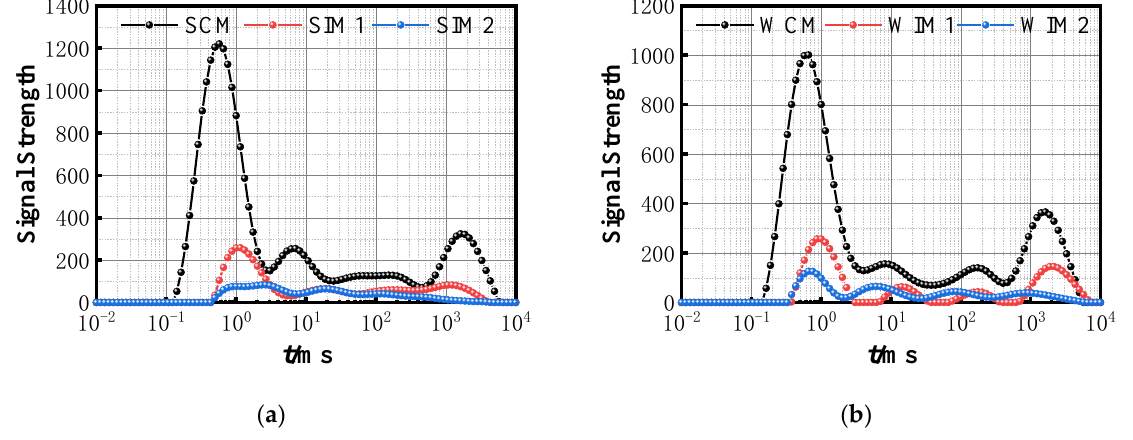
Figure 12. T 2 spectrum of different specimens: ( a ) 7 d; ( b ) 28 d.